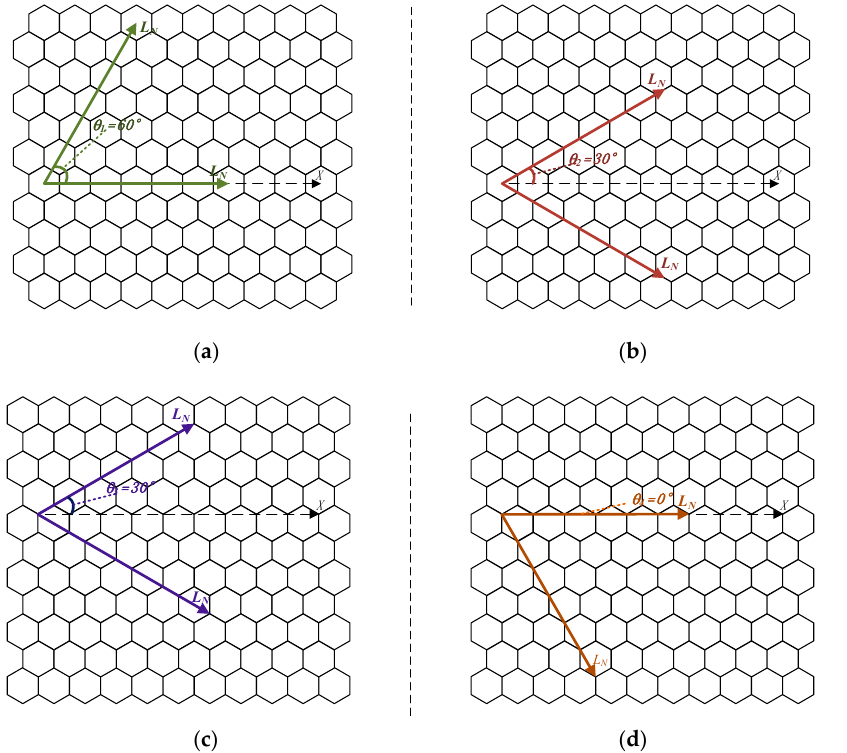
Figure 6. Various Split Grid Types of a Hexagonal Grid. ( a ) Starting from the central node θ 1 = 60°; ( b ) Starting from the boundary node θ 2 = 30°; ( c ) Starting from the central node θ 3 = 30°; and ( d ) Starting from the boundary node θ 4 = 0°.